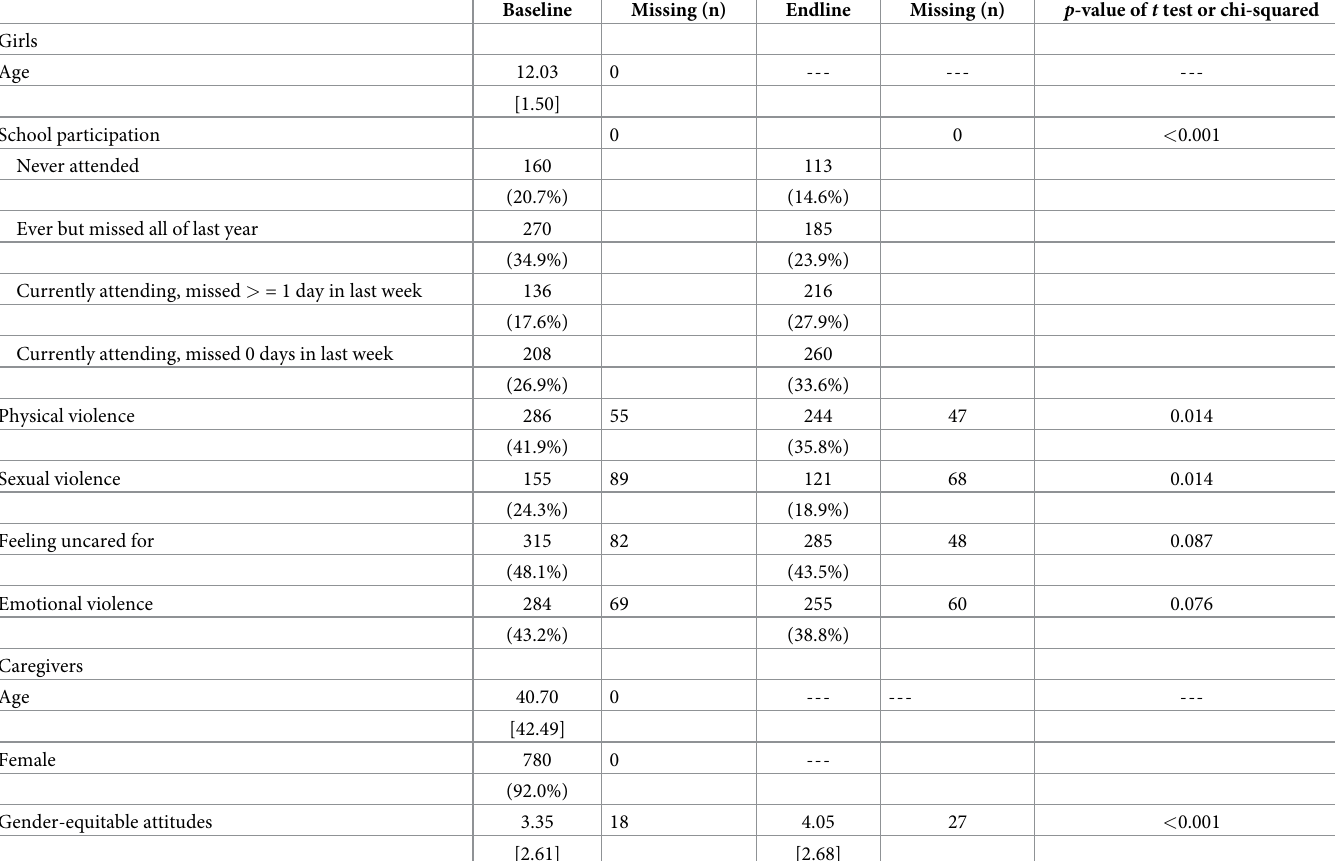
Table 1. Variables of interest, baseline and endline ( n =